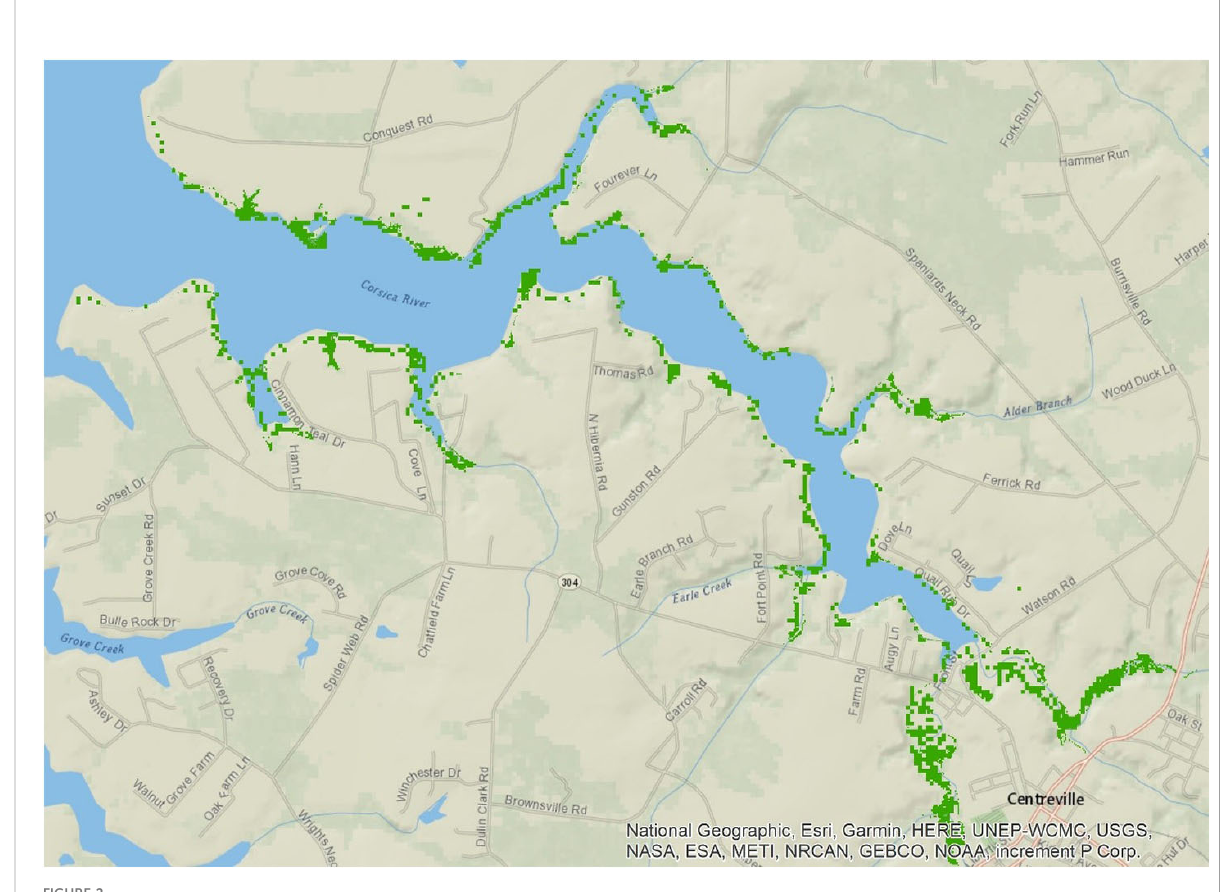
FIGURE 2 Map of the location of tidal wetlands (green) in the Corsica estuary, which are mostly distributed in the upper estuary and